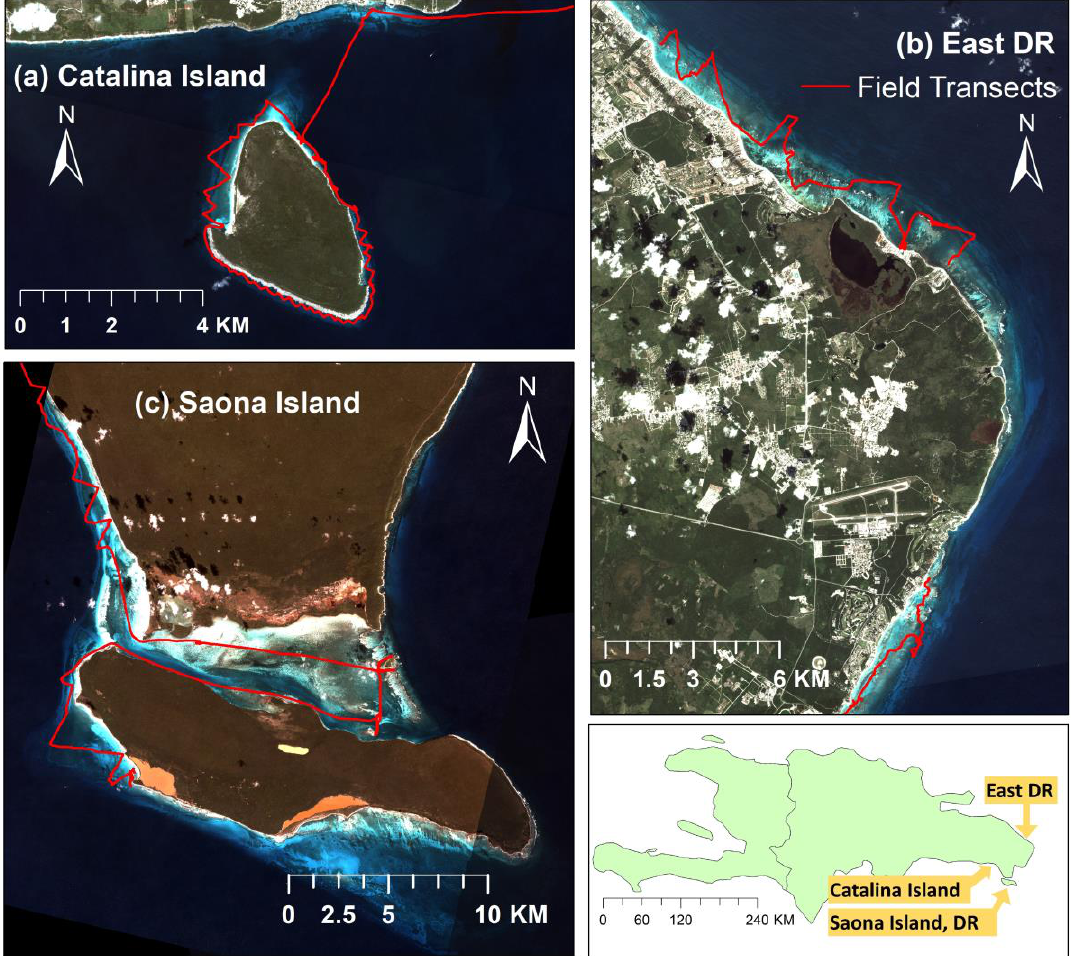
Figure 1. Planet Dove mosaic imagery (shown in RGB true color) covering three study sites within the Arrecifes del Sureste marine sanctuary in southeastern Dominican Republic (DR): Catalina Island ( a ), eastern Dominican Republic ( b ), and Saona Island ( c ). Field data transects are shown as red lines. The general location of the study region is provided in the lower right panel.